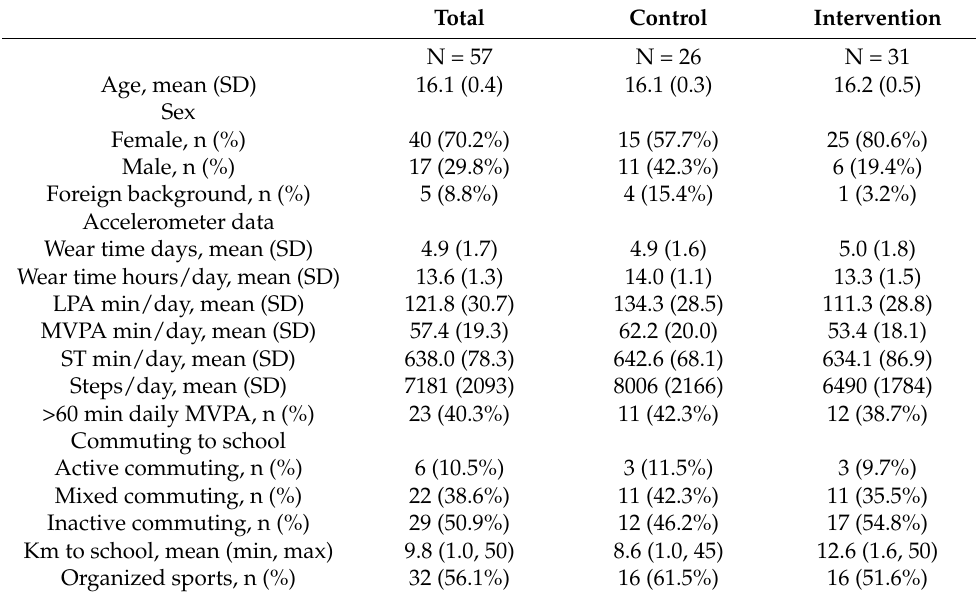
Table 1. Characteristics of the study population and crude accelerometer data at baseline